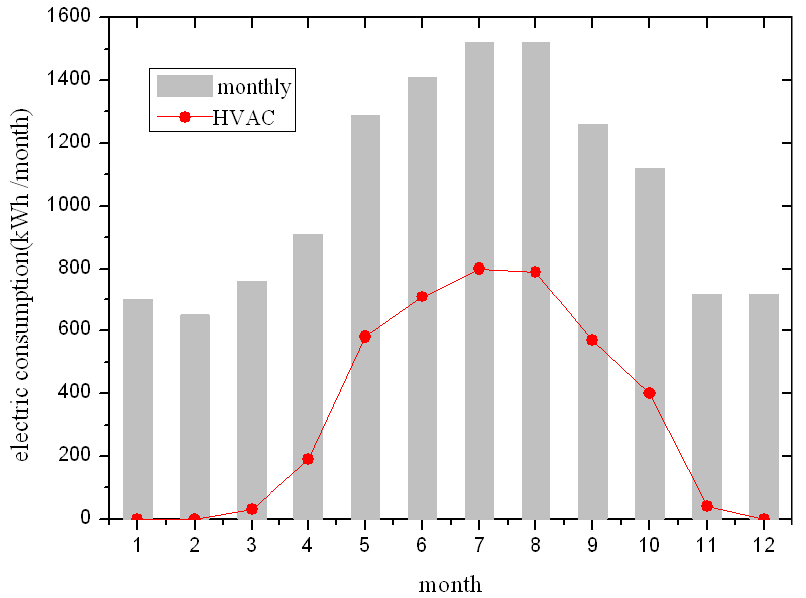
Figure 6. Monthly energy consumption of the baseline